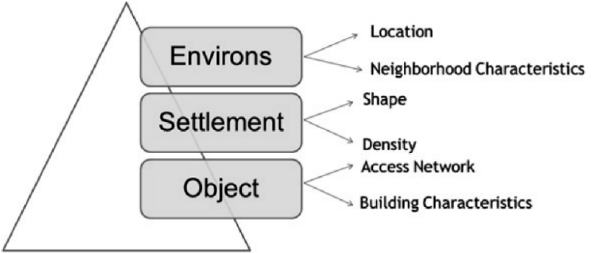
Figure 4. Slum ontology—indicators associated with the three spatial levels [5].